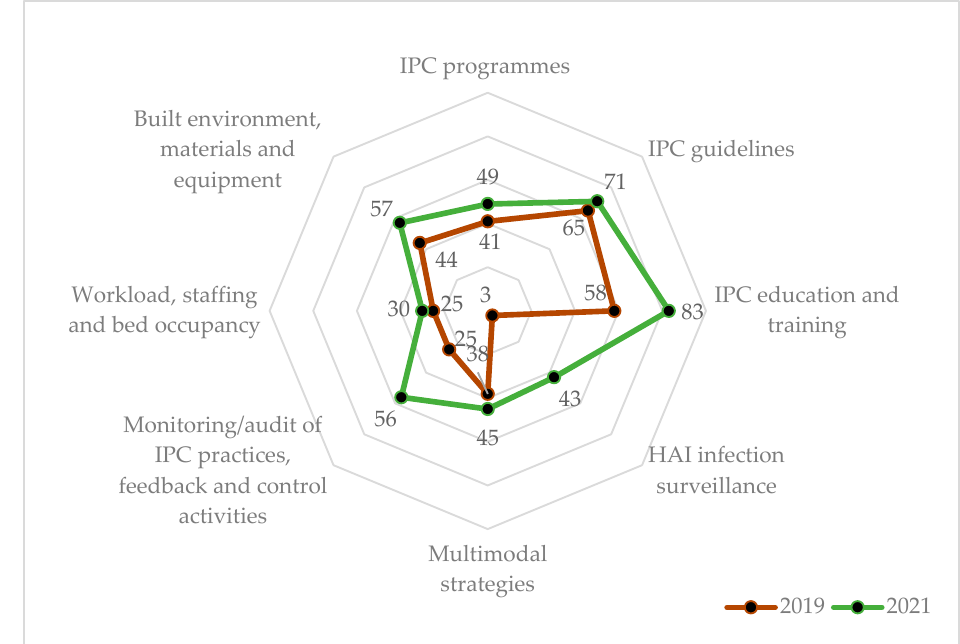
Figure 3. Median IPC compliance percentage scores across eight core components in the four regional hospitals during 2019 (pre-COVID-19) and 2021 (COVID-19 era), Sierra Leone. Note: The radar chart shows the IPC component score emanating from the centre (0%) expanding outwards to a maximum of 100%. The 2021 scores (green line) lie outside the 2019 scores (red line), indicating overall improvement in all the components of IPC. Abbreviation: IPC = Infection, Prevention and Control; HAI = Healthcare Associated Infection